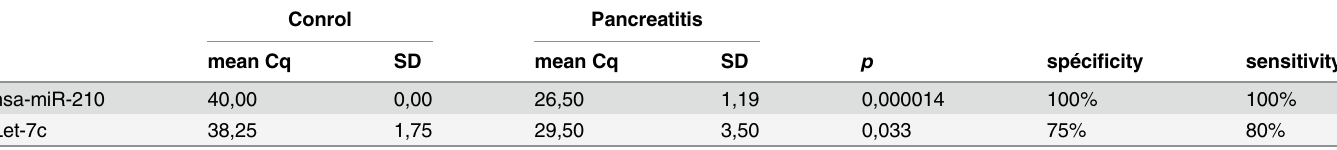
Table 4. Average Cq values, sensitivity and specificity of the candidate